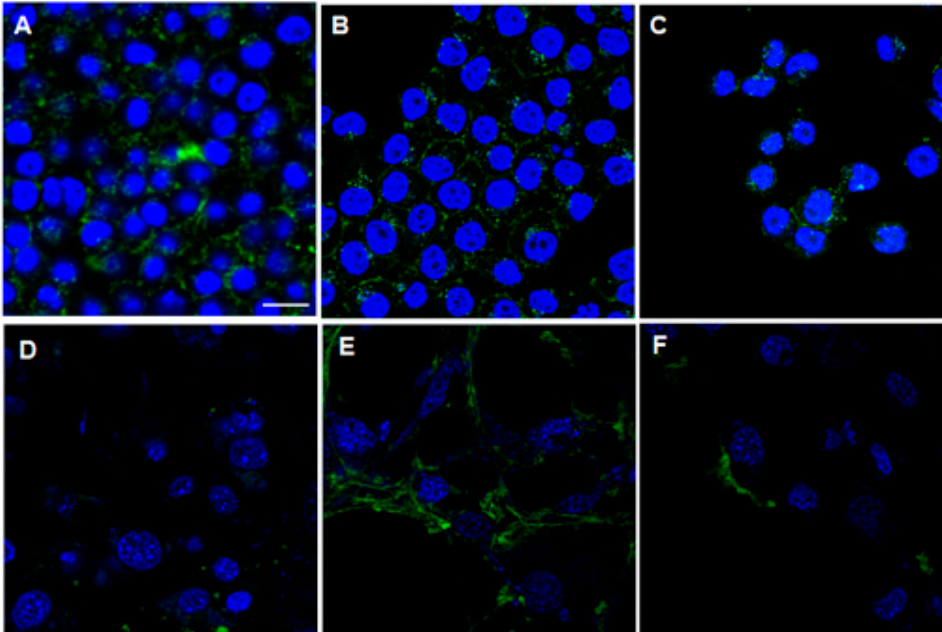
Figure 3. Conforcal fluorescence imaging of FITC-CAPs in cell lines. KB ( A − C ) and 3T3-L1 ( D − F ) cells treated with 10 µ M FITC-CAPs (green) for 1 h. Nuclei were stained by Hoechst 33342 (blue). Fluorescence images were taken with a confocal laser scanning microscope. Scale bar = 20 μ m.